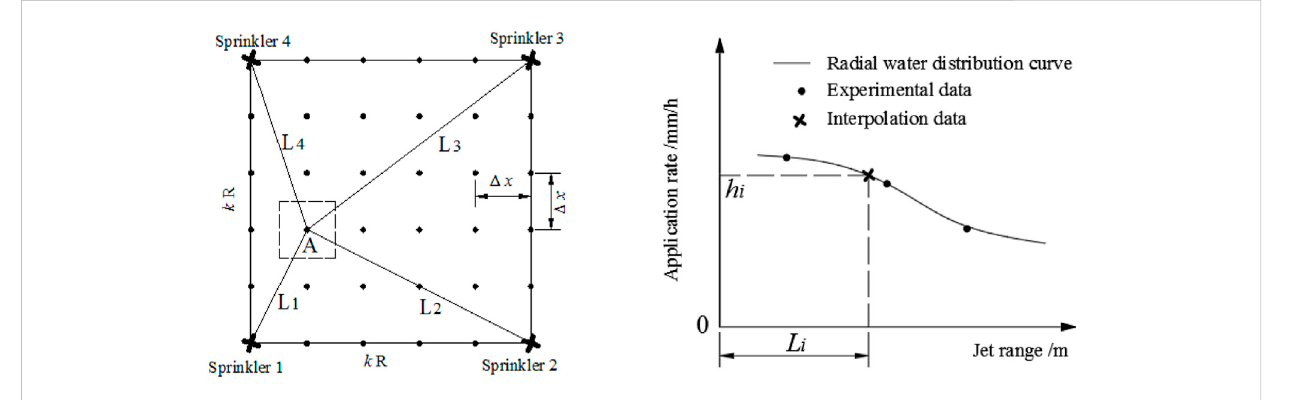
FIGURE 3 Schematic diagram of combined irrigation